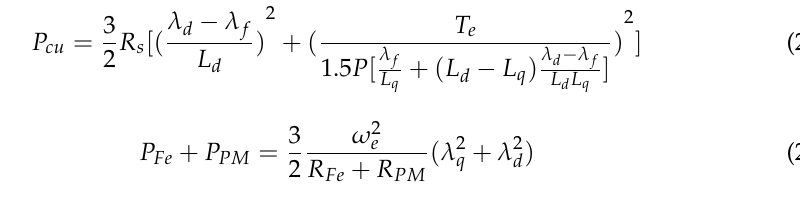
Figure 15. ECM of PMSMs with predictable core loss and PM loss: ( a ) d -axis; ( b ) q -axis [30].